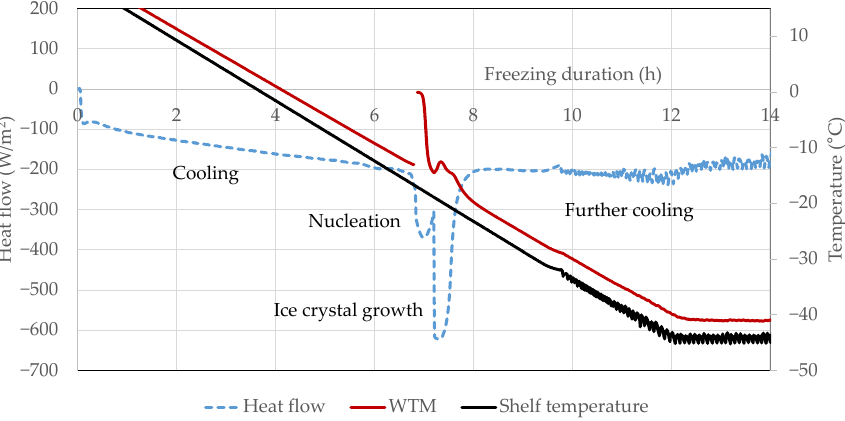
Figure 14. Heat flux and product temperature data for the freezing step of water.